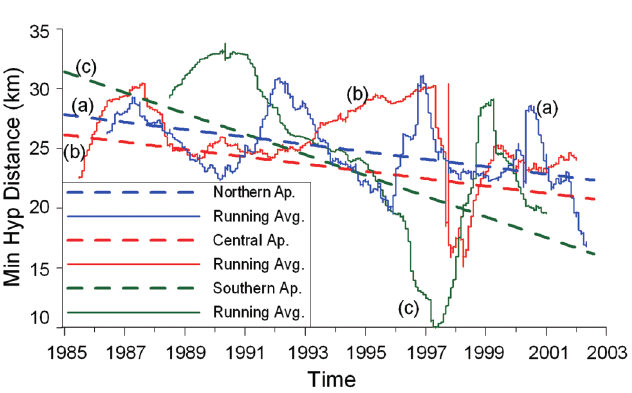
Fig. 3. Monthly averages (continuous lines) of minimum hypocentral distance like in fig. 2, but relative to (a) Northern Apennines (blue), (b) Central Apennines (red), and (c) Matese-Irpinia in Southern Apennines (green). The dashed lines represent the linear fit of the minimum distance versus time.